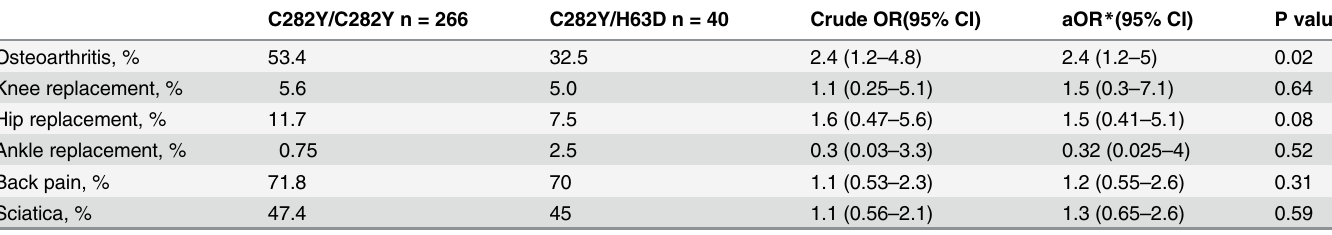
Table 3. Prevalence of osteoarthritis, joint replacement, back pain and sciatica by